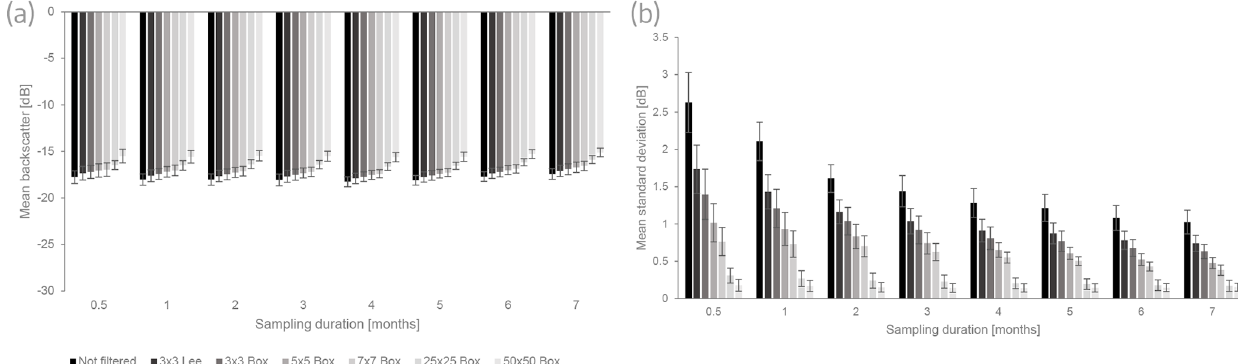
Figure 4. Average backscatter (a) and average standard deviation (b) of the pixels within 10 patches of sand for different sampling durations and filter sizes. Bars indicate the 95% confidence interval. Lee – Lee filter. Box – boxcar filter.